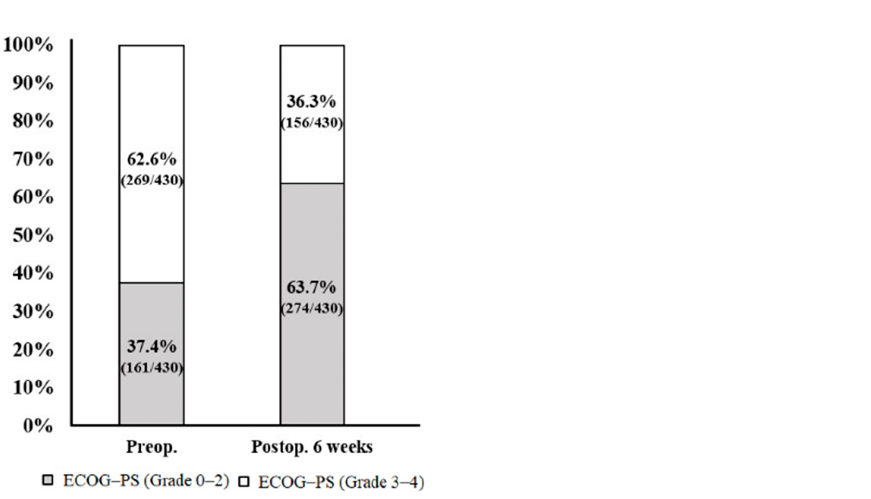
Figure 3. Preoperative and postoperative ECOG-PS and ambulatory status of patients. Table 5. Preoperative and postoperative performance status based on ECOG-PS grade.